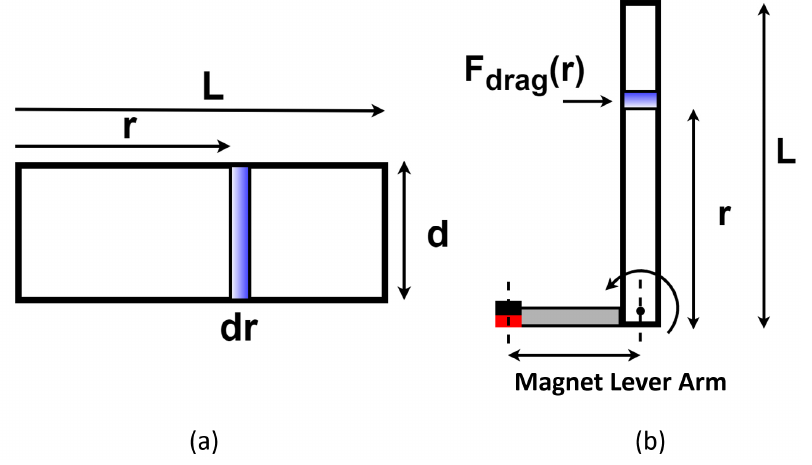
Figure 7. Representative scheme to calculate total torque due to drag force on the tail: ( a ) simplified cross-sectional tail area; ( b ) arms of the oscillating mechanism.